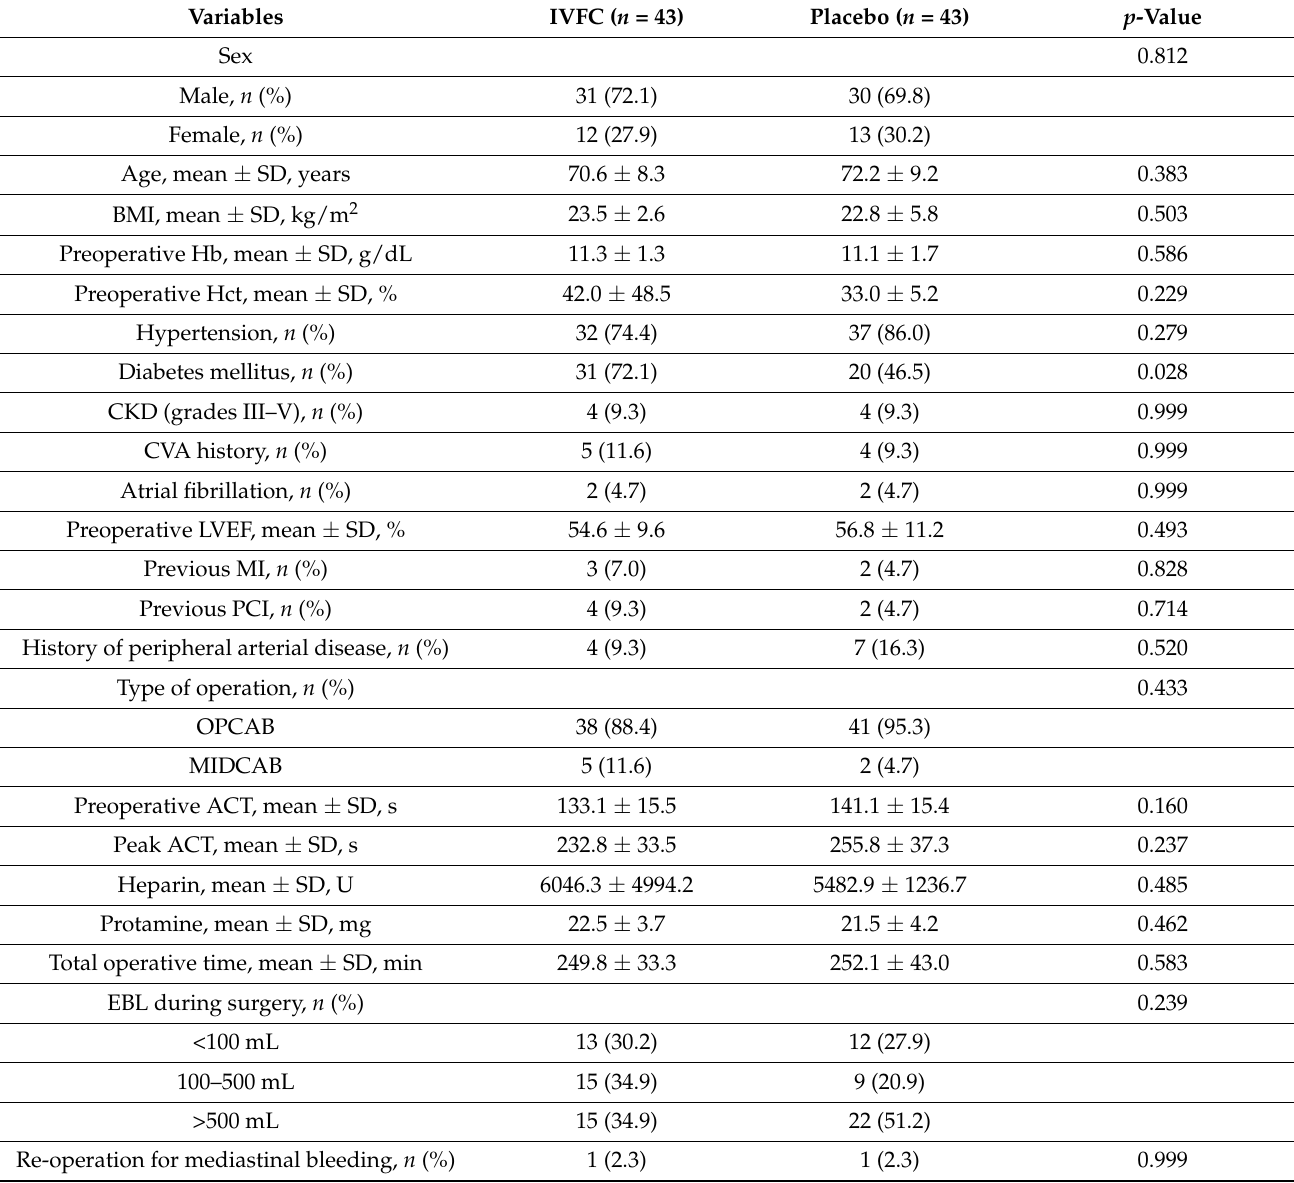
Table 1. Baseline characteristics and operative data for patients with preoperative iron deficiency